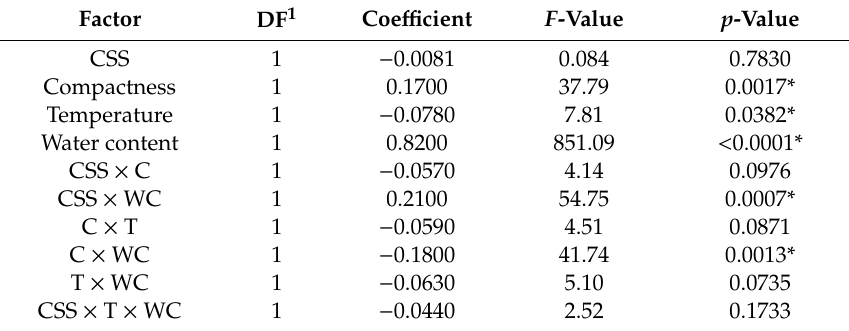
Table 5. Results coe ffi cient estimates of coded factors, F -value, and p -value.